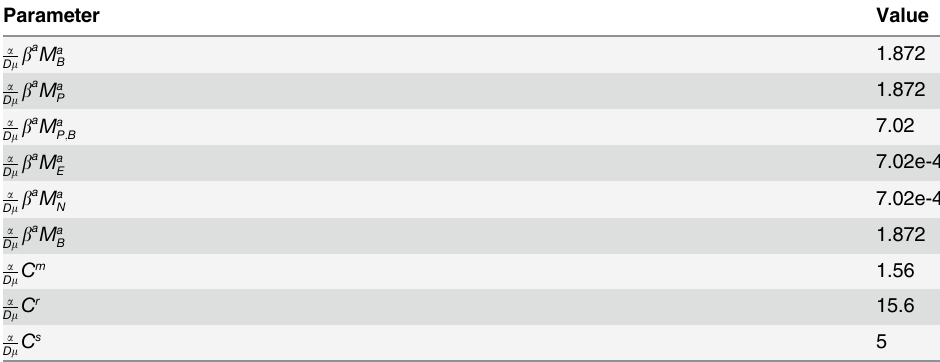
Table 1. Composite non-dimensional parameter values used for simulation. The parameter α is the time scale (an hour) and D is the diameter of an IMC (7 μ m). We can consider the α and D scaling the damping vis- cosity coefficient, μ , then the parameters in the table represent a ratio of force exerted on the IMC by move- ment through the heterogeneous medium and the force exerted by the adhesion, repulsion, migration and stochastic